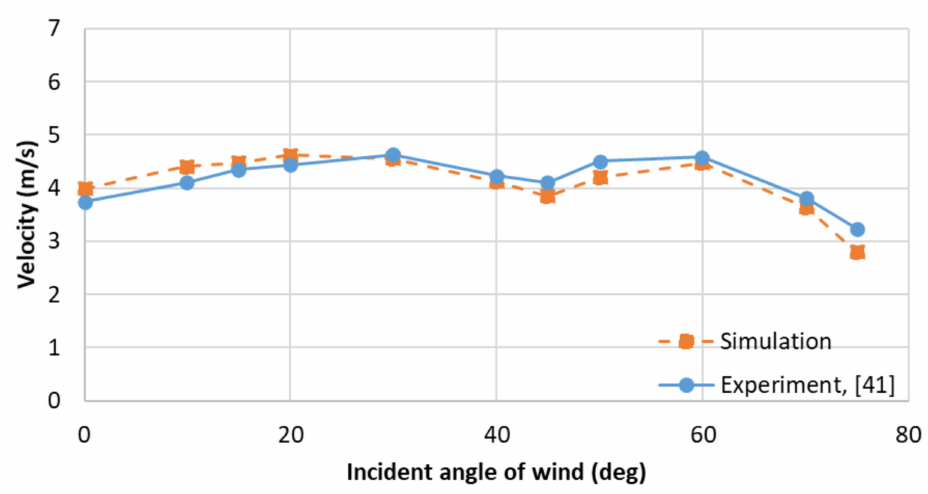
Figure A5. Comparison of simulated and experimental results for air velocity through the opening.